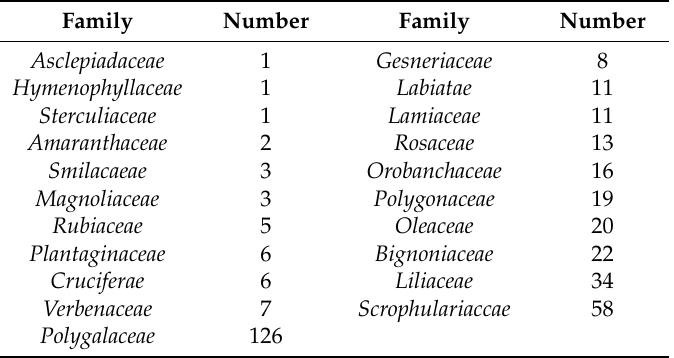
Table 1. The Family Distribution of CASEDs.